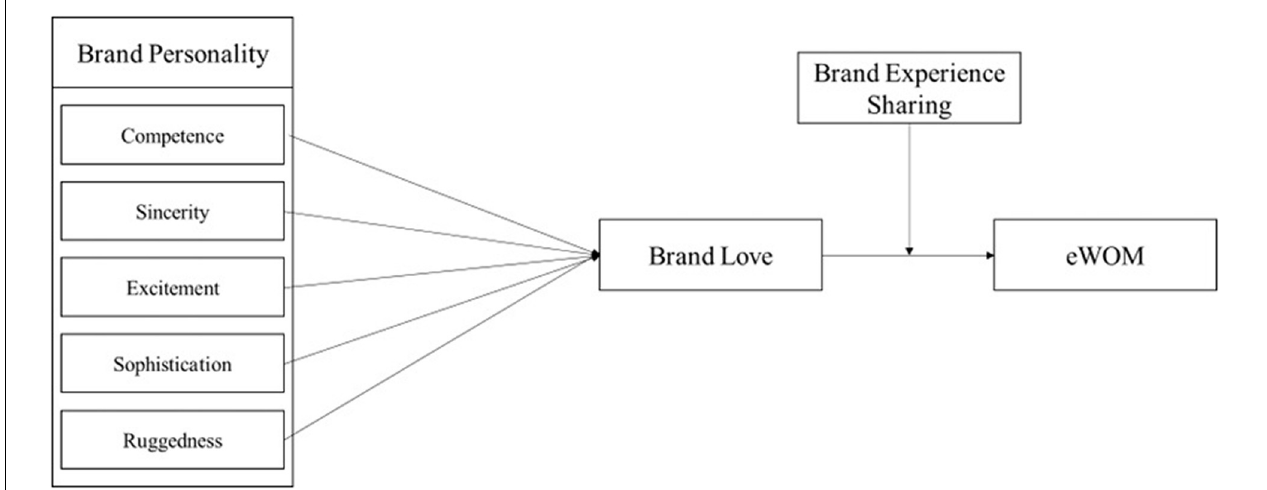
FIGURE 1 | Research